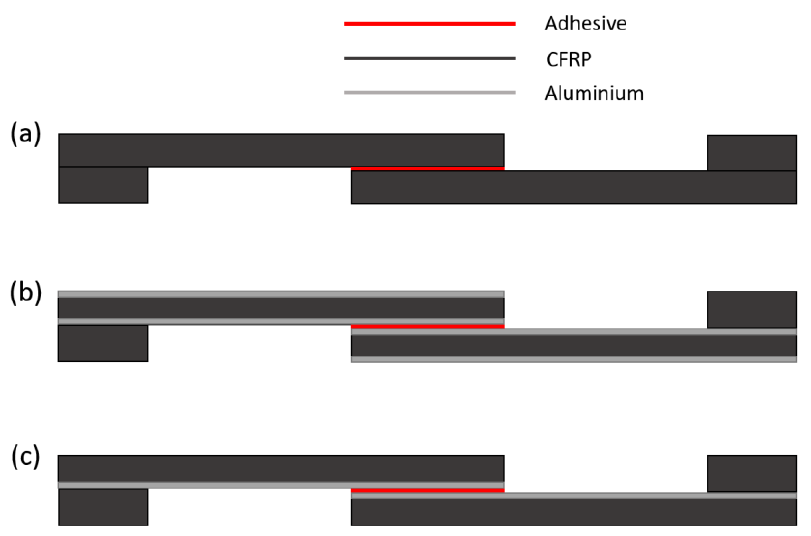
Figure 2. Schematic representation of ( a ) CFRP-only adherend, ( b ) Al-CFRP-Al adherend, and ( c ) CFRP-Al adherend.